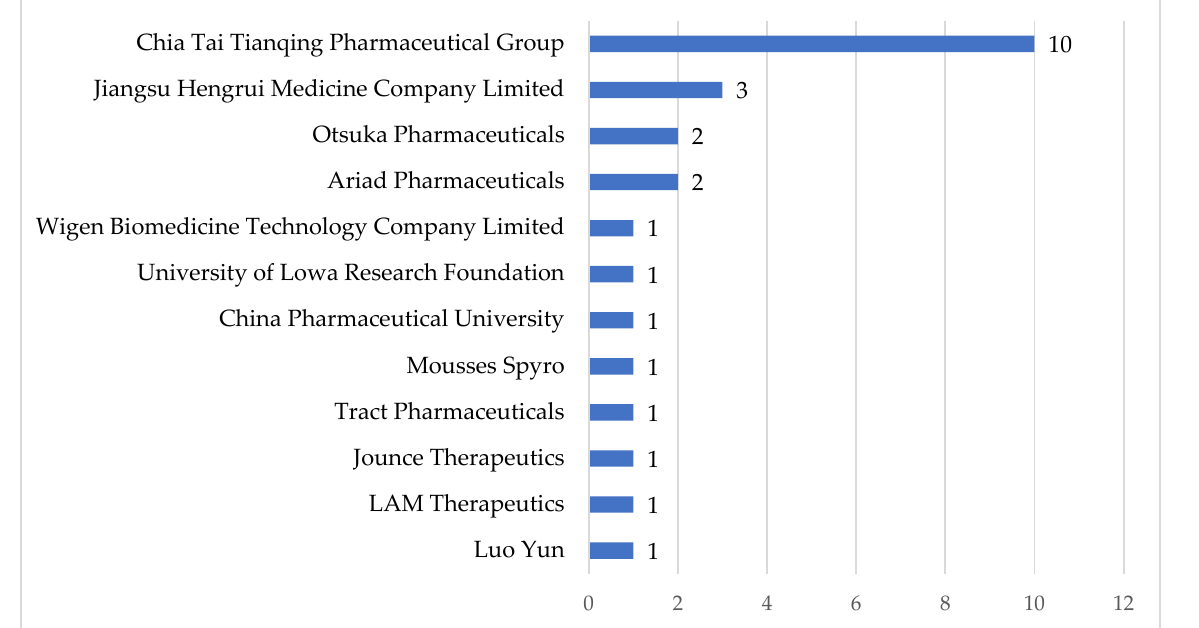
Figure 6. The number of patent families filed by different applicants.